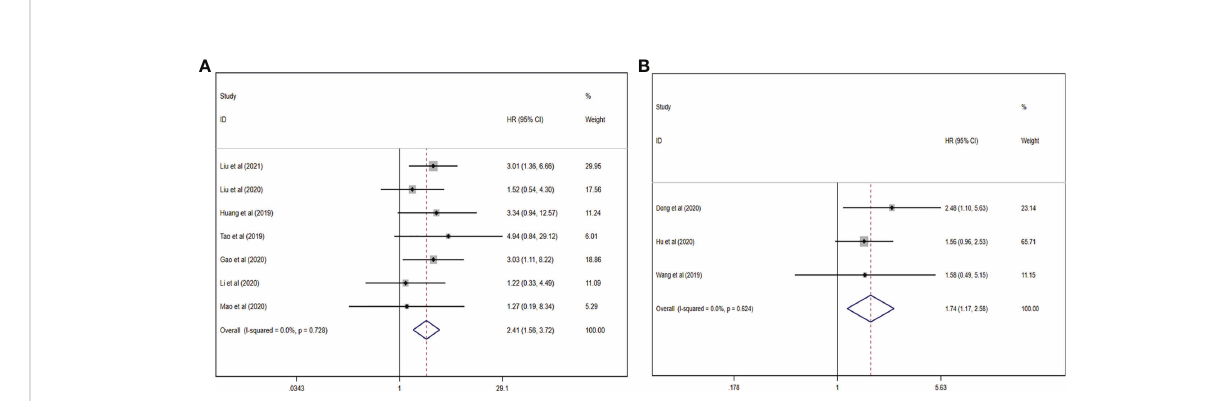
FIGURE 7 Forest plots for the association between circRNAs and estimating HR in PCa. (A) Upregulated circRNAs. (B) Downregulated circRNAs. HR, hazard ratios; PCa, prostate cancer; circRNAs, circular